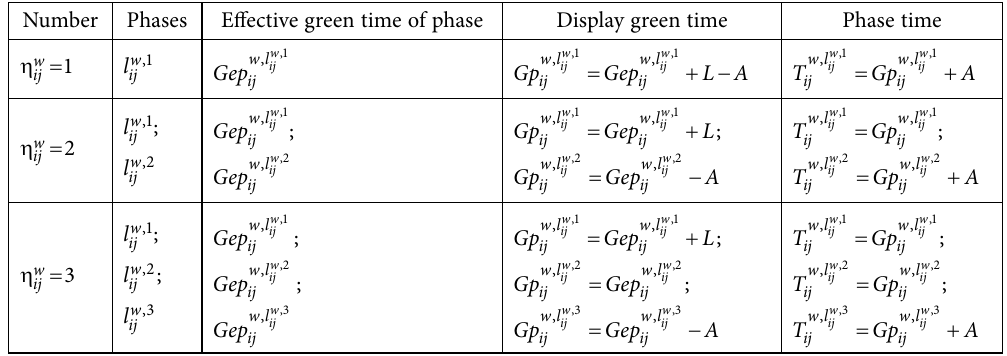
Table 3. Parameter relations of movement s